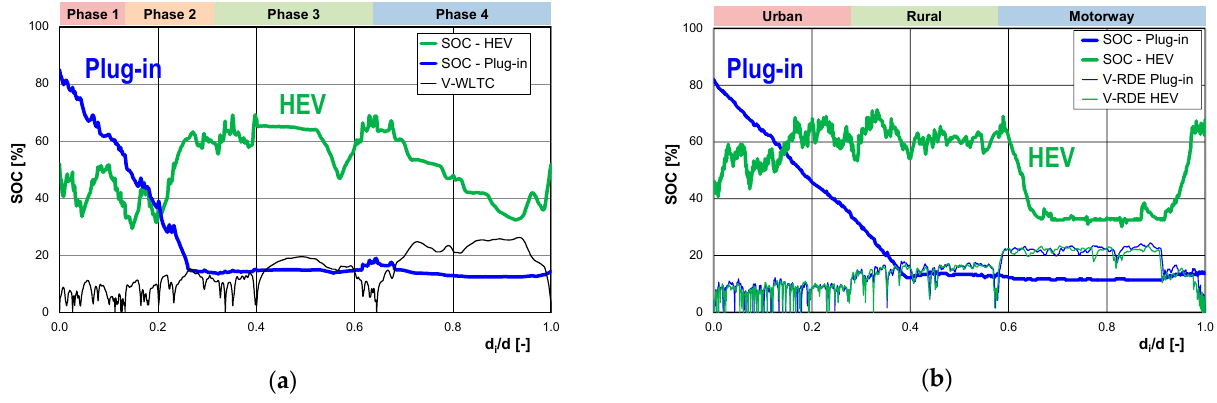
Figure 37. Comparison of SOC for plug-in and HEV vehicles in the test: ( a ) WLTC; ( b ) RDE. The HEV was equipped with a system that did not allow for initial SOC formation.